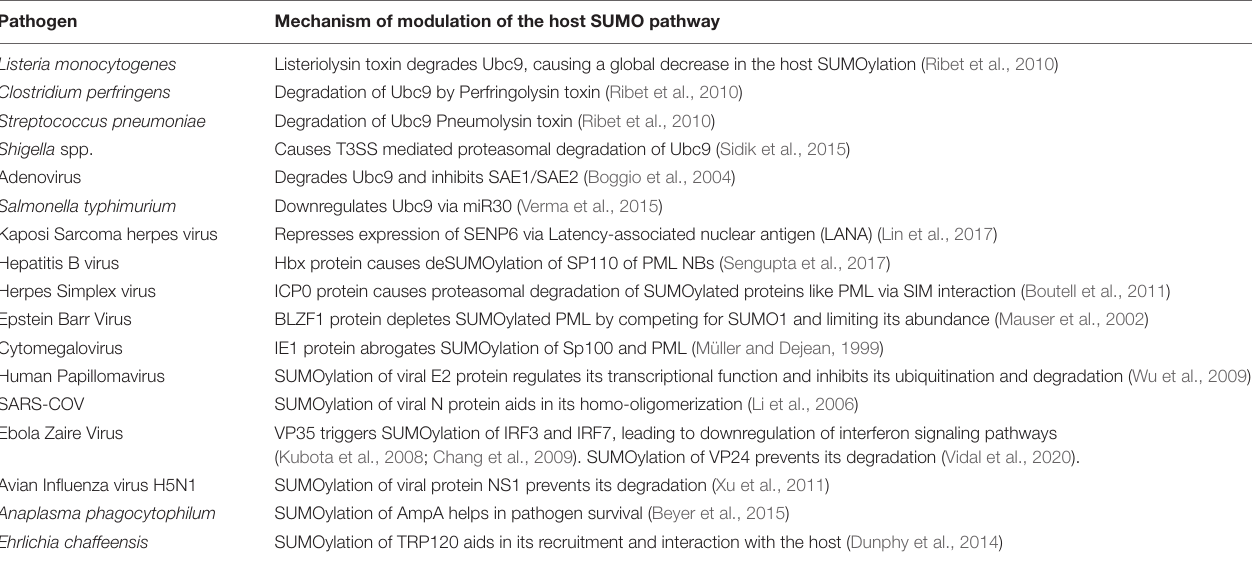
TABLE 2 | List of parasites modulating host SUMOylation machinery and host or parasite effector protein SUMOylation.